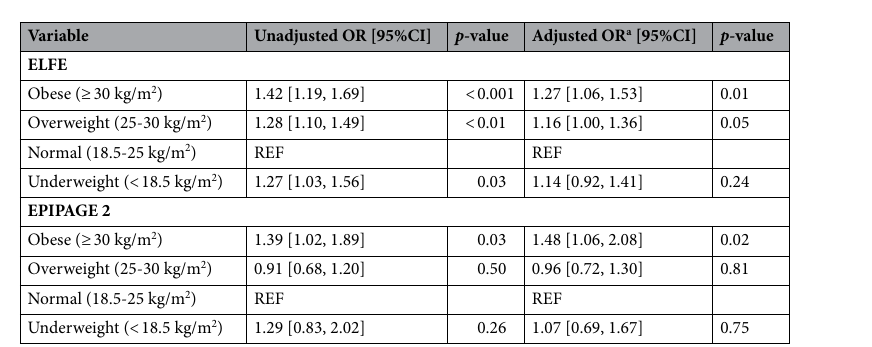
Table 3. Association between maternal pre-pregnancy body mass index and offspring hyperactivity- inattention symptoms (SDQ score ≥ 7) in ELFE (n = 10,898) and EPIPAGE 2 (n = 2646) at 5.5 years. a Adjusted for maternal age at birth, maternal education, household income (ELFE), household socioeconomic category (EPIPAGE 2), parity, sex, psychological problems during pregnancy (ELFE), anxiety symptoms (EPIPAGE 2), singleton pregnancy (EPIPAGE 2), maternal physical activity during pregnancy (ELFE), maternal healthy diet score during pregnancy (ELFE), maternal alcohol intake during pregnancy (ELFE), maternal smoking during pregnancy, child age at evaluation, gestational age, breastfeeding, cause of prematurity (EPIPAGE 2), childcare at 2 years, screentime at 2 years (ELFE), HOME score (EPIPAGE 2), difficulties falling asleep at 2 years (ELFE) and frequent night waking at 2 years (EPIPAGE 2). Missing covariates are imputed and weighted using